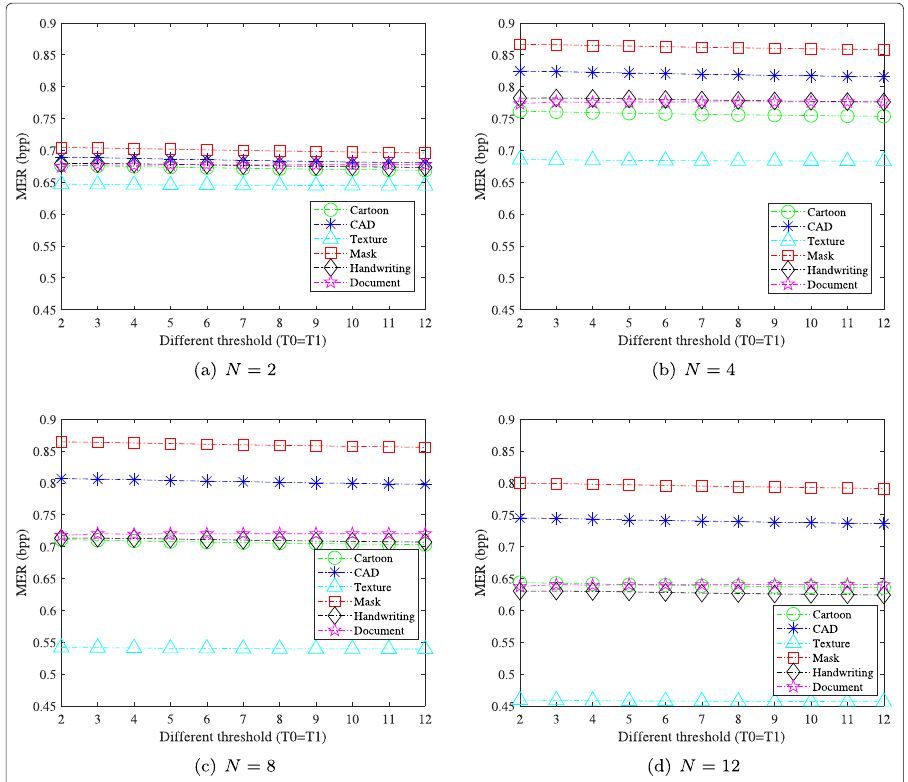
Fig. 9 Comparison of the maximum embedding rate (MER) with compression thresholds T 0 ( = T 1 ) changing for four different block sizes a N = 2, b N = 4, c N = 8, and d N = 12. Six classical binary images, (8) Cartoon, CAD, Texture, Mask, Handwriting, and Document, are tested in this